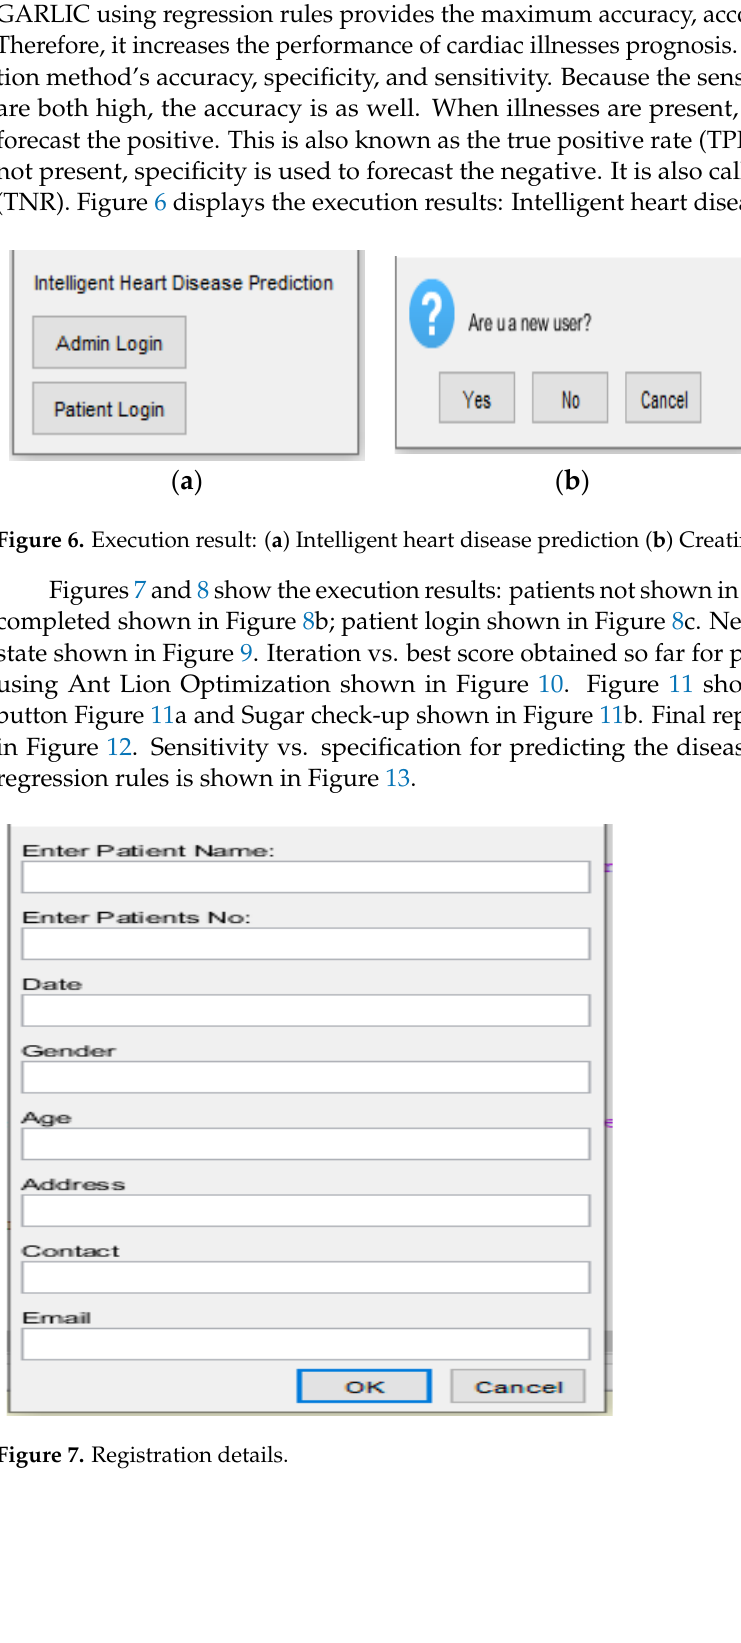
( c ) Figure 8. Execution results: ( a ) Patient no ( b ) Registration completed ( c ) Patient login. Initially, the validation checks, Mu, and the gradient are used to acknowledge the changes in the system. In this system, to terminate the learning function, the validation checks are used, ‘Mu’ denotes the control parameter, and the gradient refers to the tan- gent of the slope. The system learning speed is 0.09, 1000 epochs are the maximum number of training allowed in the system, and 0.001 is the minimum convergence error occurred in the activity. Figure 9 displays the neural network training state. It is observed that, at the 1000 epoch, the gradient value is 0.00044341, Mu is 1 × 10 − 7 , and the validation check is zero.